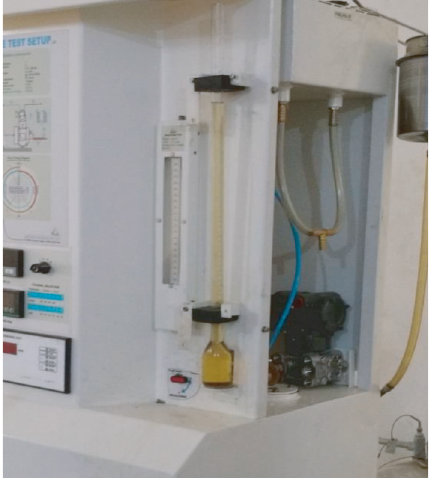
Figure 3: Fuel measurement.